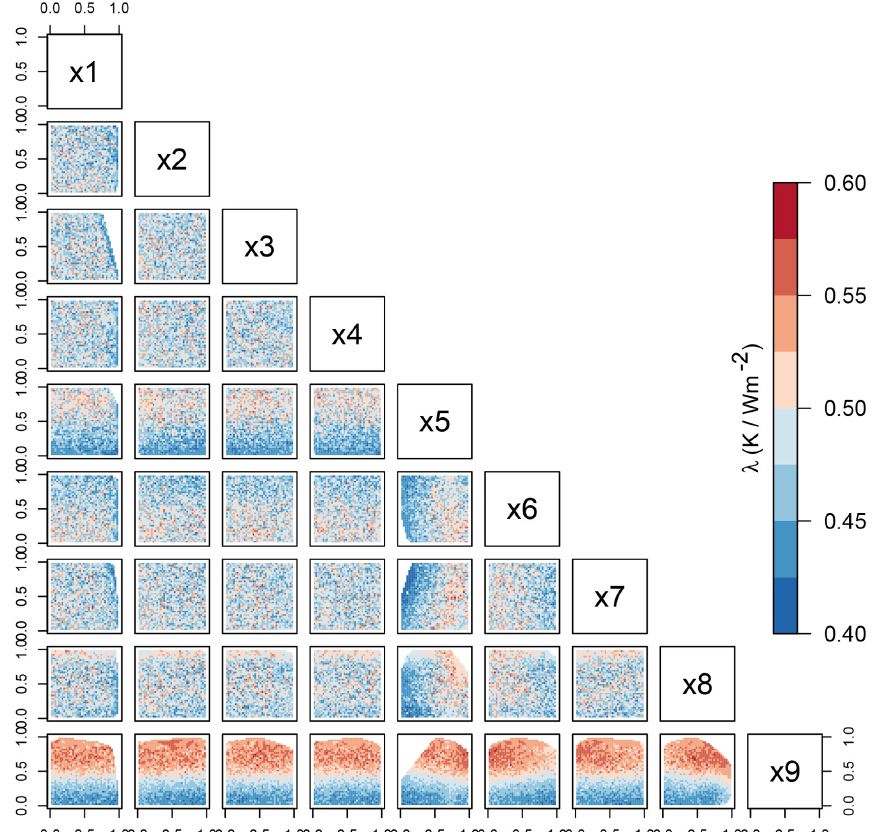
Figure 7. Color shading shows Cess climate sensitivity ( λ , units KWm − 2 ) for plausible cases as a function of each pair of input parameters ( x 1 – x 9 ). White areas indicate regions of parameter space where there are no plausible